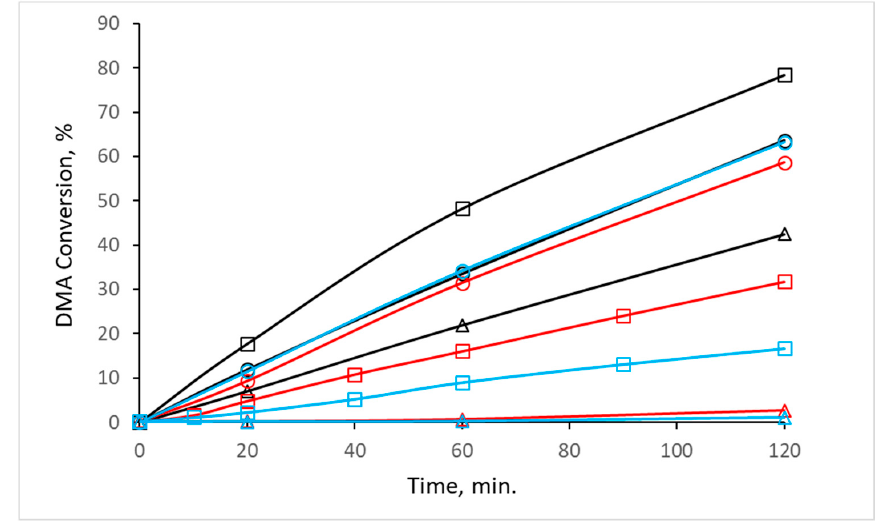
Figure 5. The DMA conversion observed on the CuZn catalysts in dependence on the temperature of their treatment in air (black line), N 2 (red line), and H 2 (blue line). Samples calcined at T = 220 °C ( ○ ), 350 °C ( □ ), 500 °C ( ∆ ).